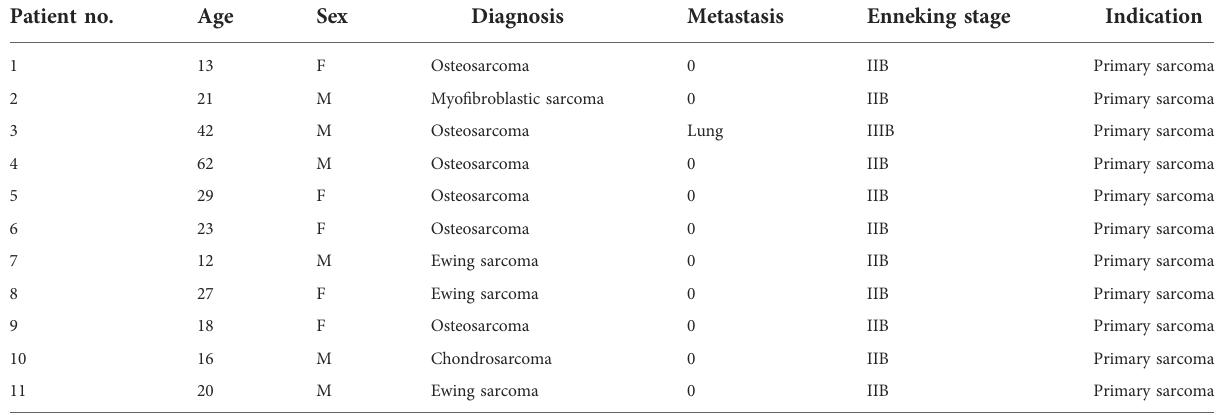
TABLE 1 Surgical indications and stage of disease. Patient no. Diagnosis